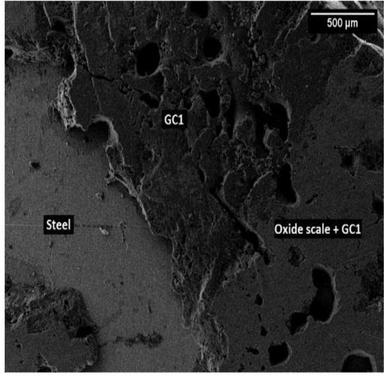
(a) fracture surfaces after torsion for a THG-5 sample joined by GC 1 and tested at 600 °C, showing mixed (i.e. adhesive/cohesive) behavior as sketched in (b), with GC1 being present on both fracture surfaces, as observed by SEM-EDS (c), with each region identified.